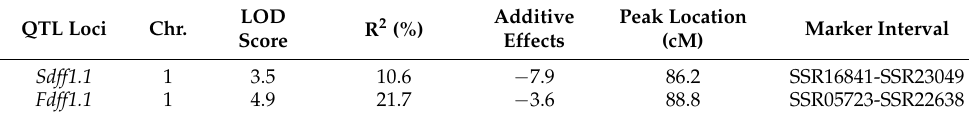
Table 4. QTLs detected on DFF by the SSR-based